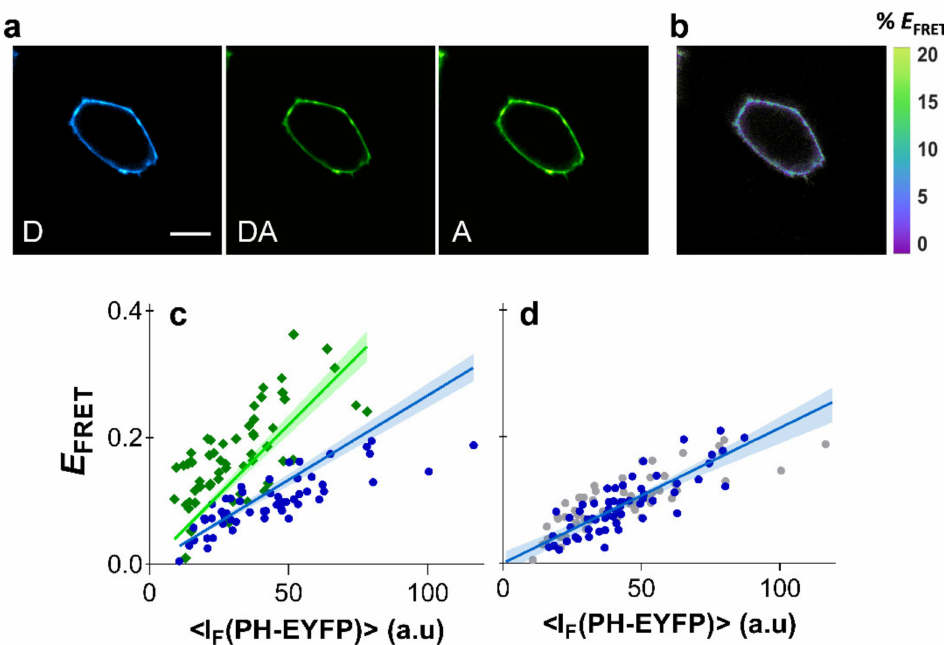
Figure 3. Clustering of PI(4,5)P 2 in HEK293T cells. FRET microscopy of HEK293T cells co-transfected with PH PLC δ -ECFP (or PH PLC δ -mTurquoise) and PH PLC δ -EYFP. ( a ) Example of confocal data ac- quired according to the three-filter cube method: D—donor channel, DA—FRET channel, A—acceptor channel. Scale bar = 5 µ m. ( b ) FRET efficiency image. ( c ) Dependence of E FRET with PH PLC δ -EYFP fluorescence intensity using PH PLC δ -ECFP (blue) or PH PLC δ -mTurquoise (green) as the donor. Each data point corresponds to the FRET signal at a segment of the plasma membrane of an individual cell (at equatorial optical sections). Lines represent the global least-squares fit of Equation (2) to both data sets, and the corresponding 95% confidence intervals are shown as shaded areas. An R C value of 0.844 ± 0.33 was recovered from the global analysis. ( d ) FRET data obtained from cells expressing PH PLC δ -ECFP and PH PLC δ -EYFP after cholesterol extraction with M β CD (blue) was identical to control cells (grey). Lines represent the least-squares fit of Equation (2) to both data sets, and the corresponding 95% confidence intervals are shown as shaded